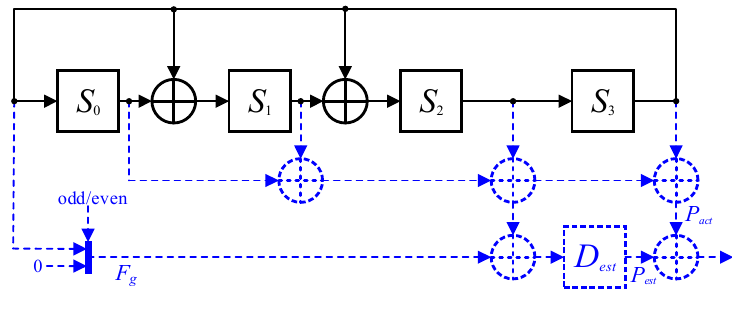
Figure 4. Structure of the proposed FT-LFSR.